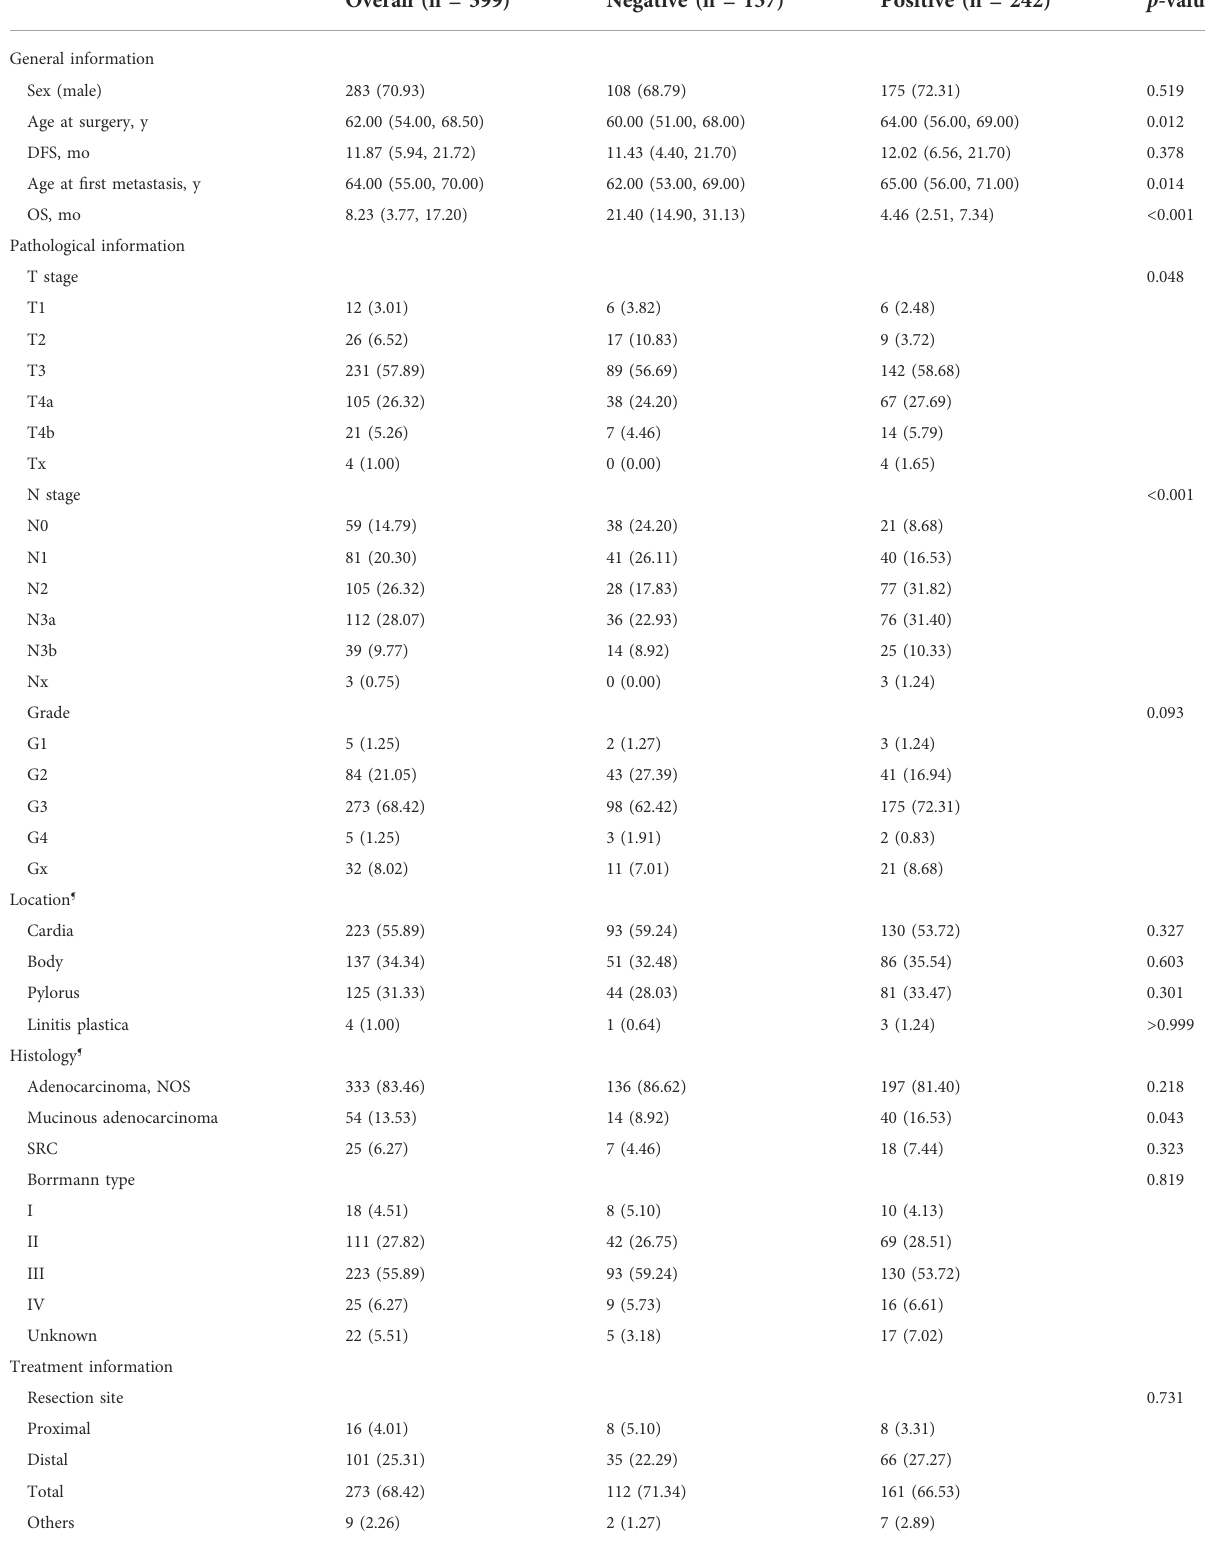
TABLE 1 Baseline characteristics of the patients enrolled for